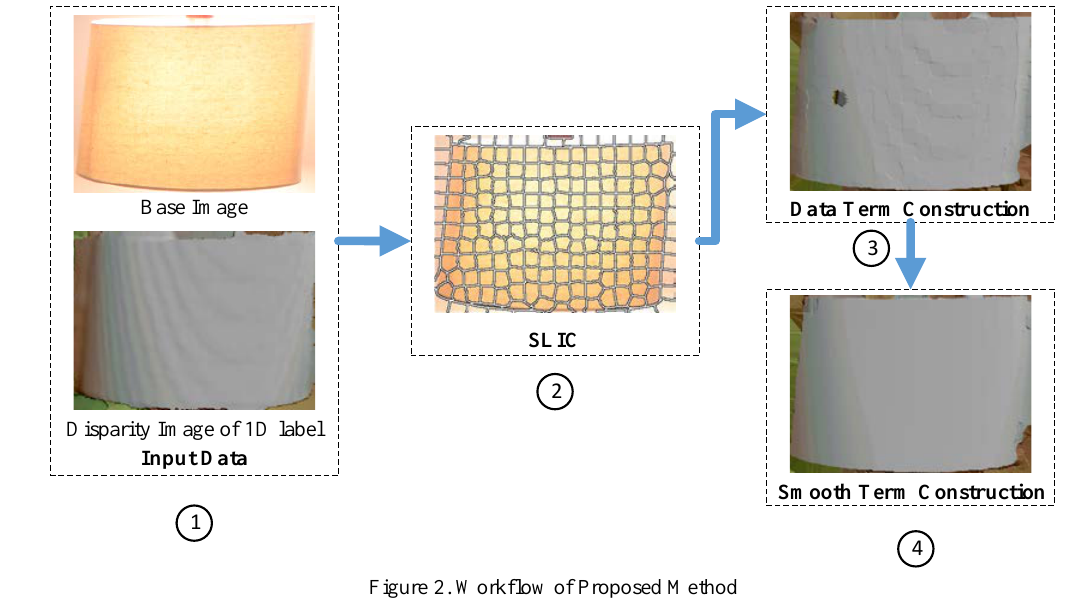
Figure 2. Workflow of Proposed